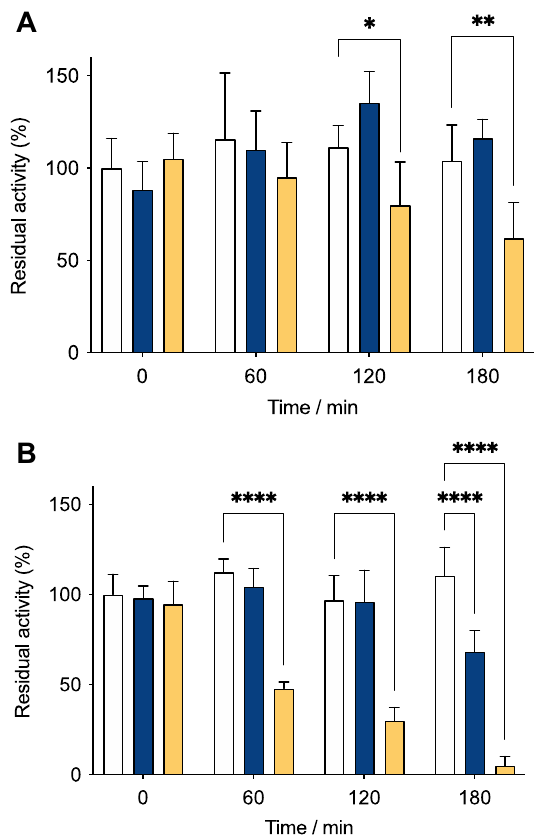
Figure 2. The enzymatic activities of G6PDH (panel A ) and 6PGDH (panel B ) are affected by AAPH-derived • ROO . Solutions of G6PDH (54 μM monomer) or 6PGDH (58 μM monomer) were incubated at 37ºC in phosphate buffer 75 mM, pH 7.4, in the absence (white bars) and presence of 10 (blue bars) or 100 (orange bars) mM AAPH. At defined times, aliquots were taken, the AAPH removed, and the enzymatic activity assessed by following NADPH release at 340 nm, as described in the Materials and methods. The data presented are means ± standard deviations of at least three independent experiments, each measured in triplicate. Statistical differences are indicated as follows: * p < 0.05, ** p < 0.01, and **** p <